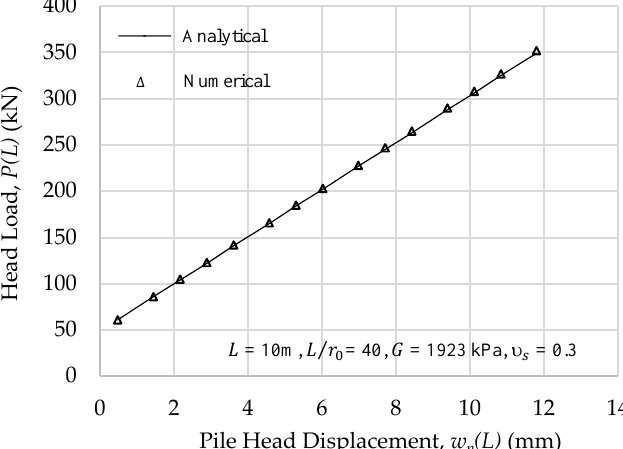
Figure 4. Pile head load (P) versus pile head displacement ( w p ), comparison of the analytical closed- form solution suggested from Guo [14] and the adopted FE model in elastic soil.